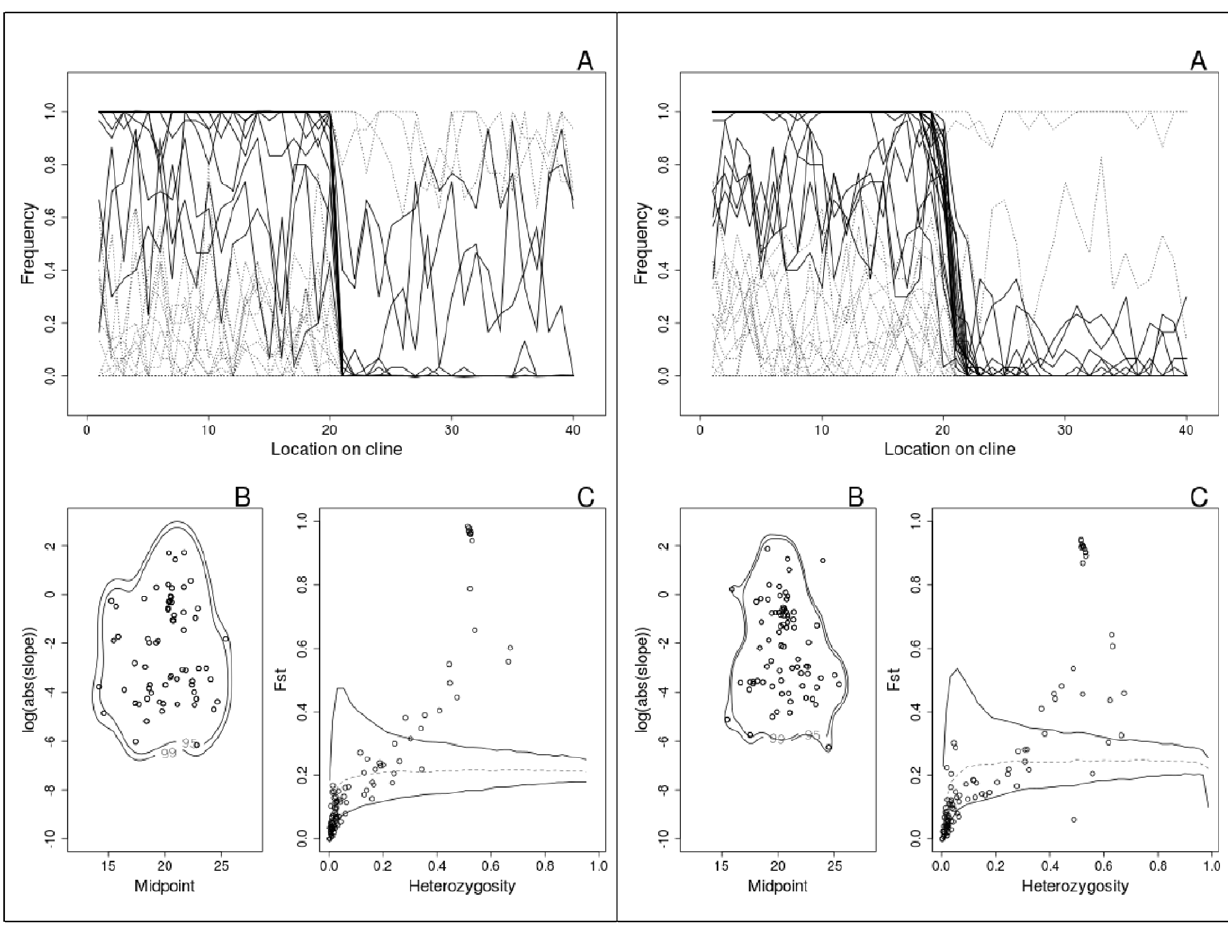
Figure 4. Summaries of two simulations. In the sub-figure on the left the stepping-stone dispersal rate is 0.4 ( N e m ); on the right, N e m is equal to 4. In each sub-figure, panel A illustrates the distribution of allele frequencies along the cline for simulated loci. All clines are adjusted so that higher allele frequencies are on the left. Bold lines indicate loci deemed to be under diversifying selection by fdist2. Panel B shows the distribution of cline midpoints and slopes estimated using broken stick models applied to the clines in panel A . Panel C shows the results of fdist2 applied to these clines.